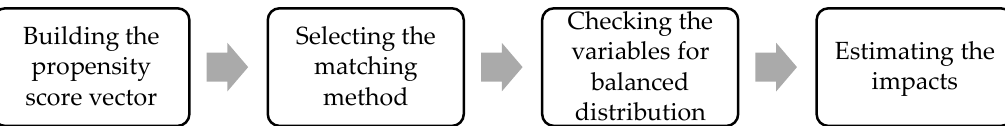
Table 2. Results of the matching procedure for the variable “labor” (in AWU, SE010). Country